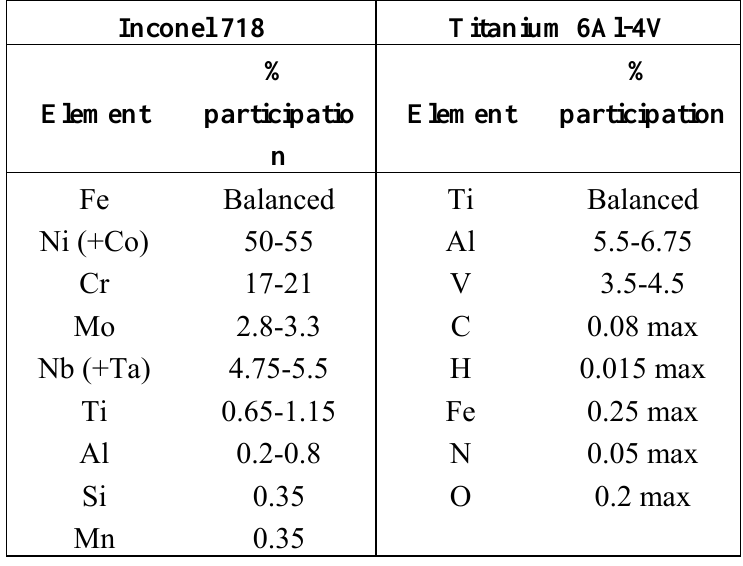
Table 1. Composition of Inconel 718 and Titanium